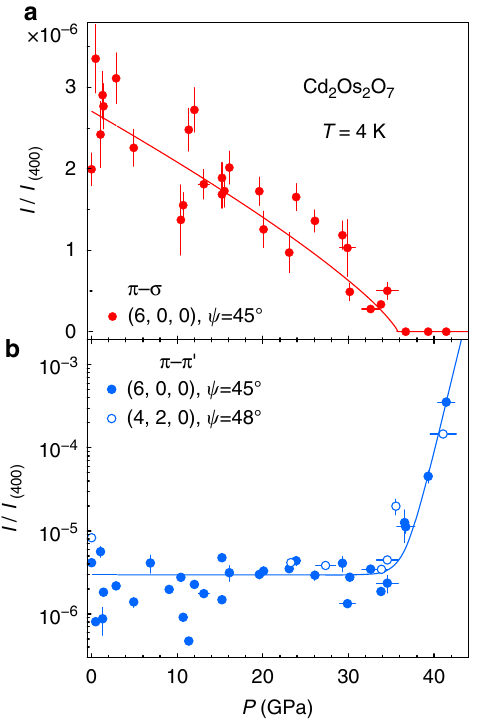
Fig. 5 Continuous magnetic and structural quantum phase transitions. a Magnetic diffraction intensity was measured at (6, 0, 0) and in the π − σ channel, with a power law fi t (solid line) to model the evolution over the whole pressure range. b Lattice diffraction intensities, measured at both the (6, 0, 0) and (4, 2, 0) orders in the π – π ’ channel, indicate a continuous switching between the Fd-3m and F-43m space groups with a phase boundary that rises effectively exponentially. All intensities were measured at 4.0 ± 0.5 K with integration of sample mosaic pro fi les at speci fi ed azimuthal angle ψ using 12.387 keV X-rays. Vertical error bars represent 1 σ s.d. counting statistics, and horizontal error bars represent the full range of pressure inhomogeneity during a